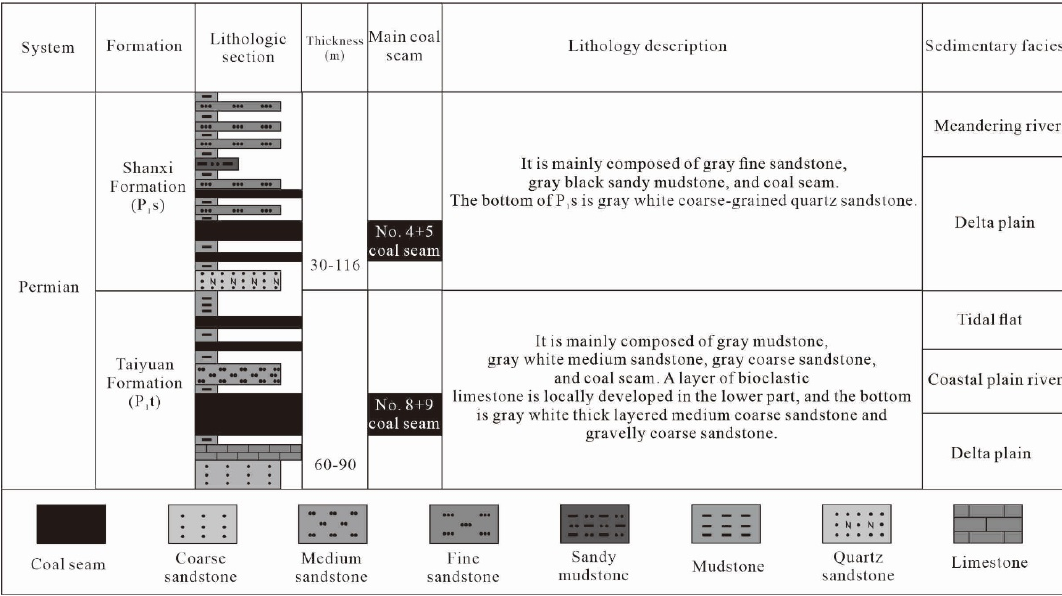
Figure 2. Lower Permian stratigraphic column in the Baode block .